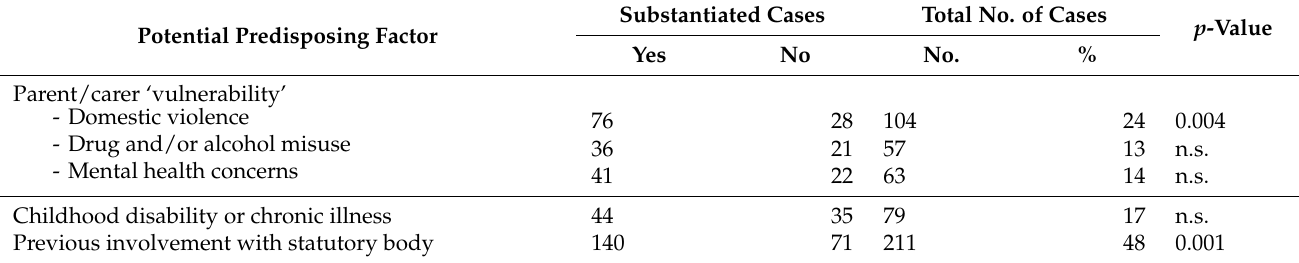
Table 2. Potential predisposing factors to abuse in referred cases.